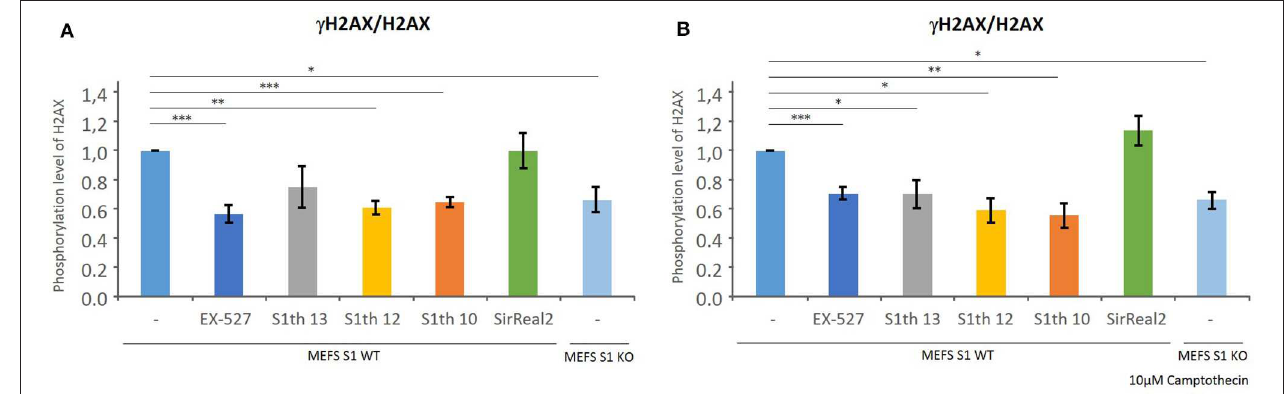
FIGURE 4 | Quantification of γ H2AX/H2AX levels in MEF cells after Sirt1 depletion or incubation with various inhibitors by western blot analysis (original western blots: Supplementary Figure 4 ) with anti- γ H2AX and anit-H2AX. γ H2AX/H2AX levels are decreased in Sirt1 KO cells and upon addition of EX-527 (10 µ M), S1th 10 (30 µ M), S1th 12 (20 µ M), or S1th 13 (12 µ M). The selective Sirt2 inhibitor SirReal2 (30 µ M) does not affect γ H2AX/H2AX levels. Addition of Camptothecin increases DNA damage in cells (A) γ H2AX/H2AX levels without Camptothecin; (B) γ H2AX/H2AX levels after addition of Camptothecin (10 µ M). The experiments